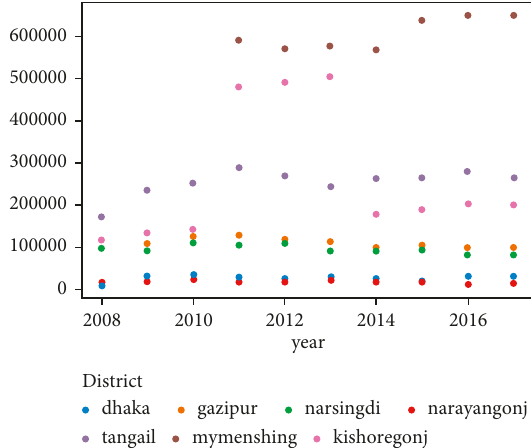
Figure 3: Year-wise (2008–2017) production of Aman.